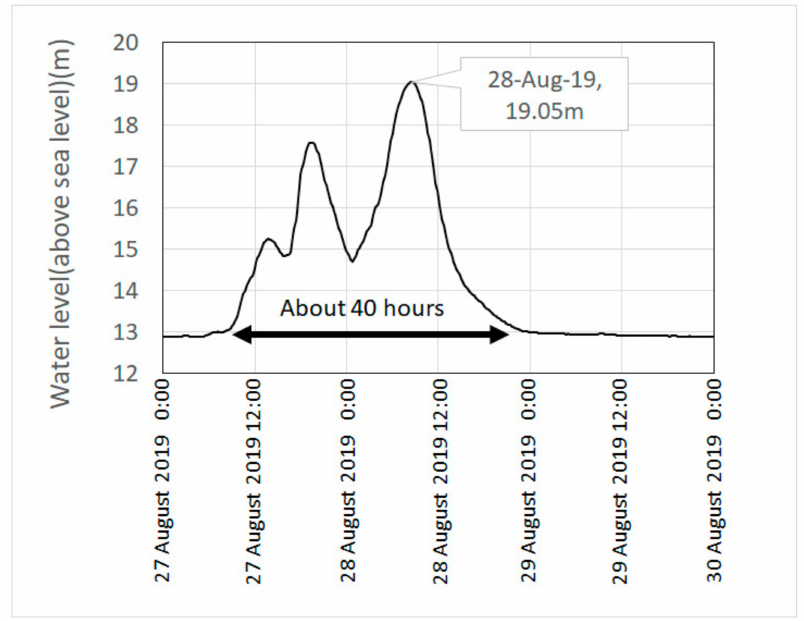
Figure 4. Changes in water level over time at point Y.